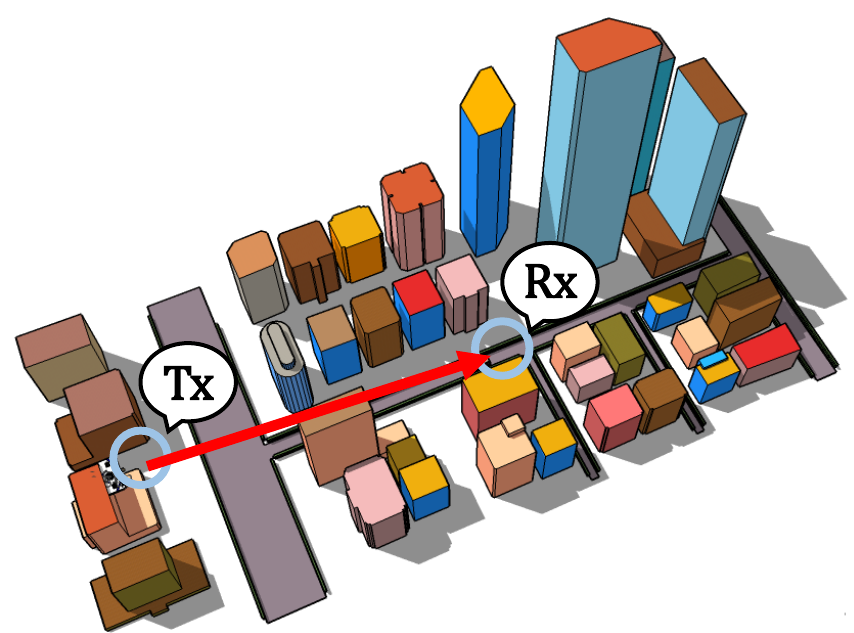
Figure 5. 3D model of the simulation scenario.